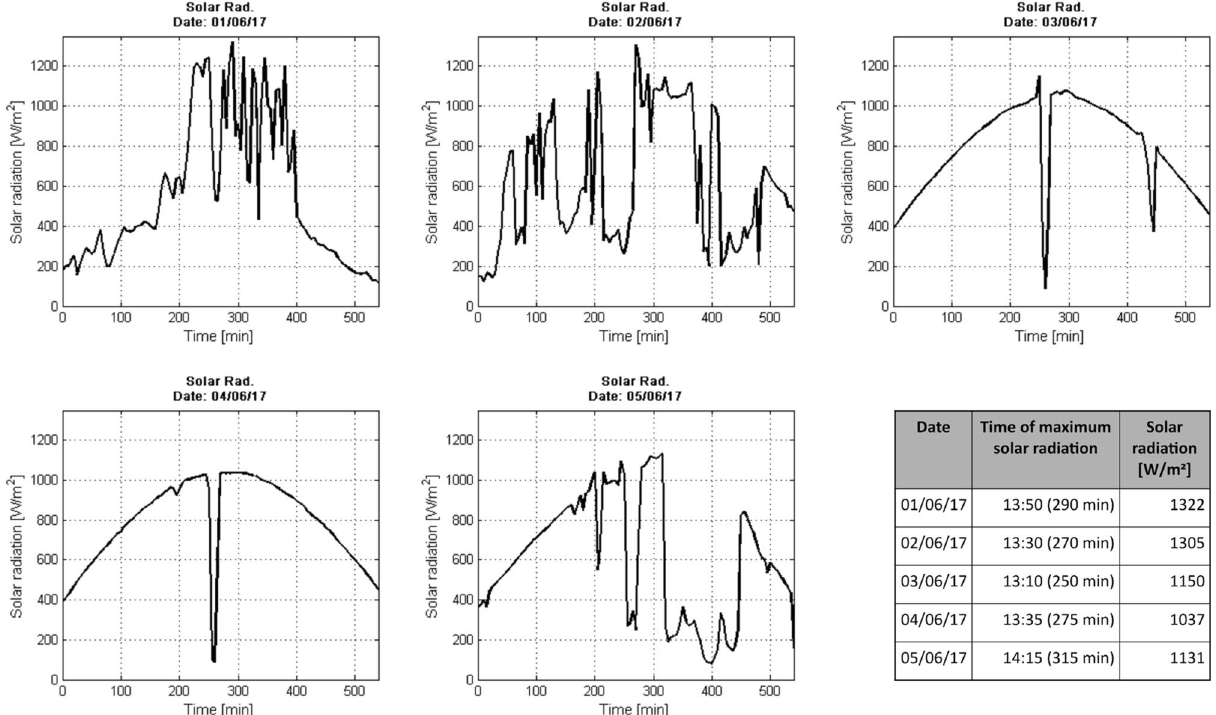
Figure 7. Solar radiation as a function of time (09:00–18:00 h) of the last five days of photoperiod and life cycle of the cochineal. The maximum solar radiation was between 13:00 and 14:20 h, recording a maximum solar radiation of 1037 to 1322 W/m 2